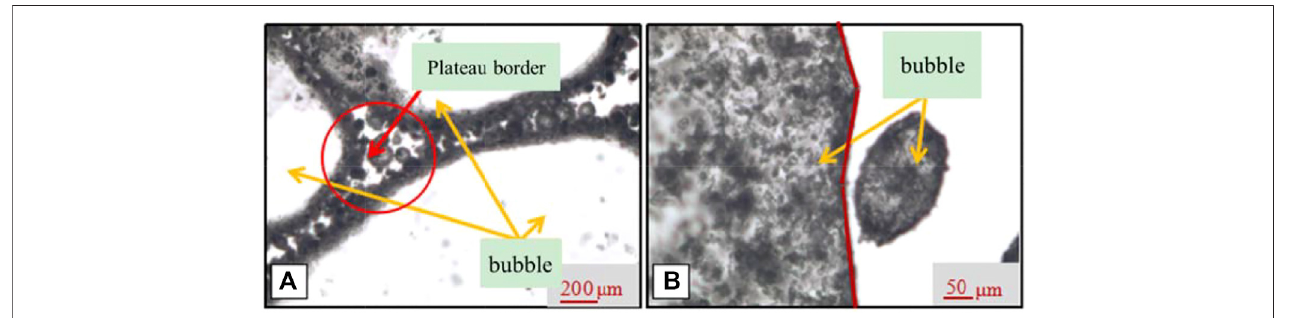
FIGURE 5 | Microstructure of foam. (A) Plateau border (B) Partial enlarged picture.